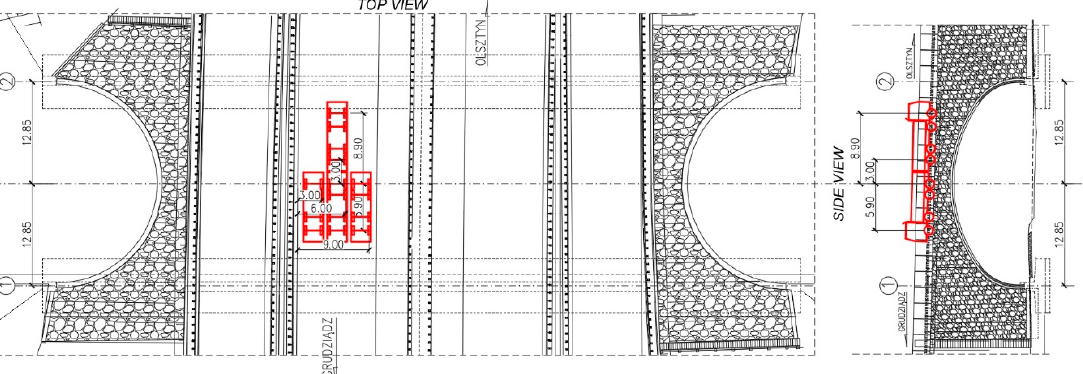
Figure 7. Schematic drawing of trucks locations during the S1 test configuration (dimensions in (m)).